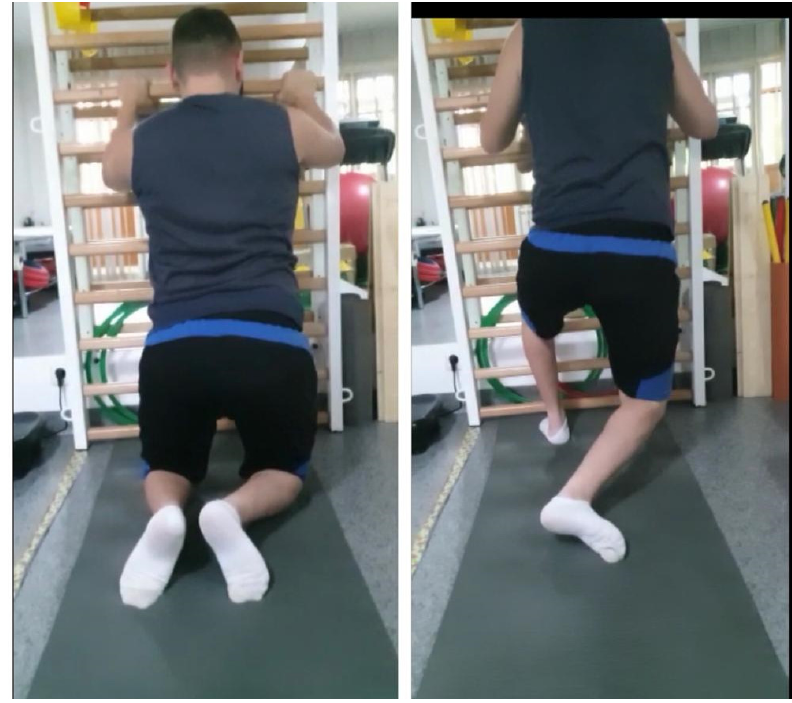
Figure 7. “The Servant Knight” position.